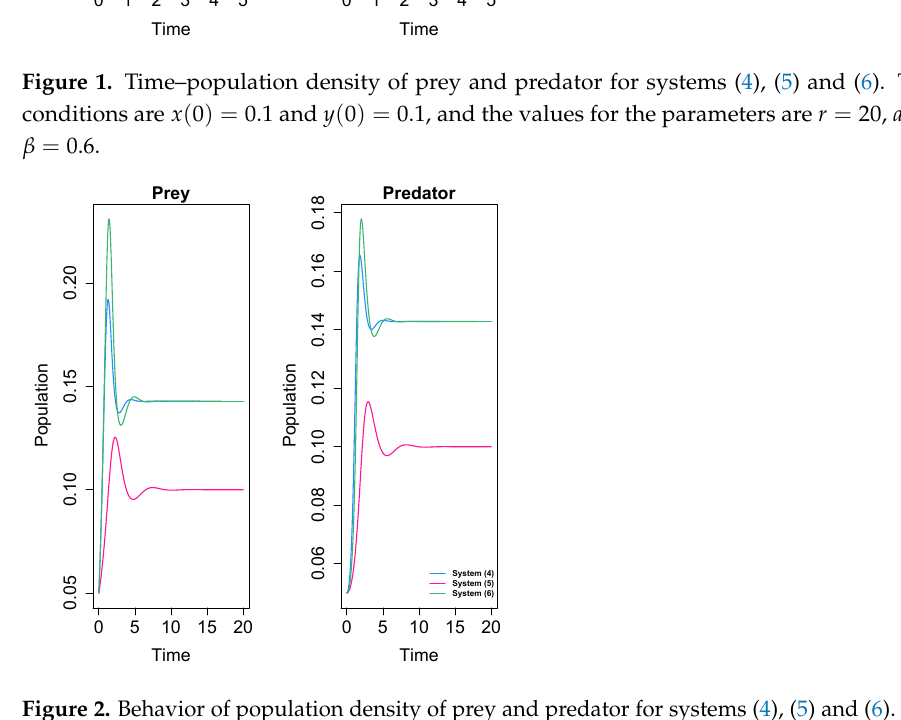
Figure 2. Behavior of population density of prey and predator for systems (4), (5) and (6). The initial conditions are x ( 0 ) = 0.005 and y ( 0 ) = 0.01, and the values for the parameters are r = 2.5, a = 15 and β =